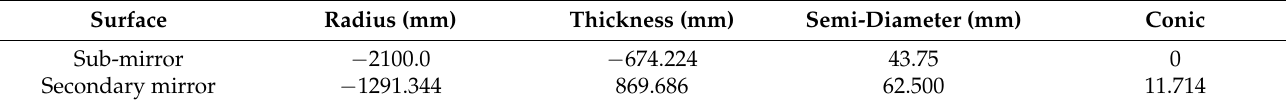
Figure 8. The configuration of the Golay3 MMT with the corrector group. Table 4. The parameters of the final Golay3 MMT.